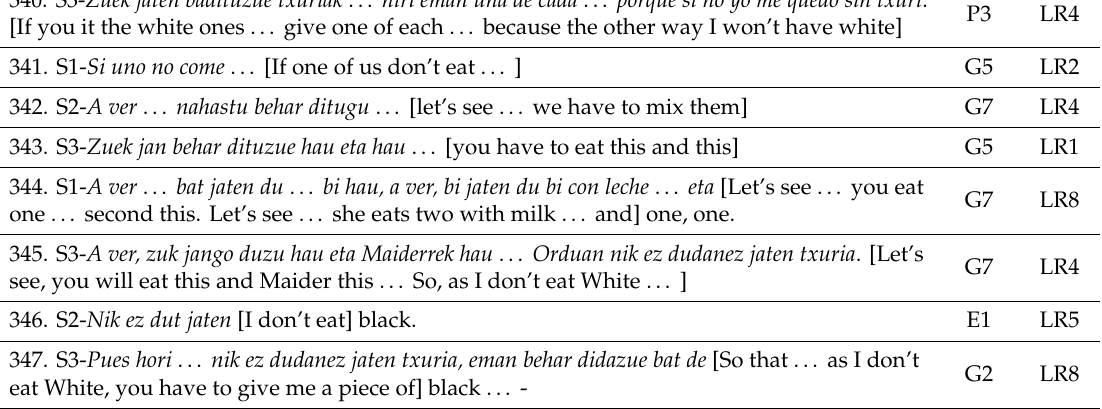
Table 7. Example from School